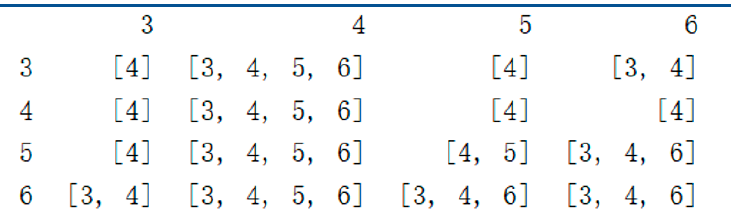
Figure 7. Lower right (running result of Python).